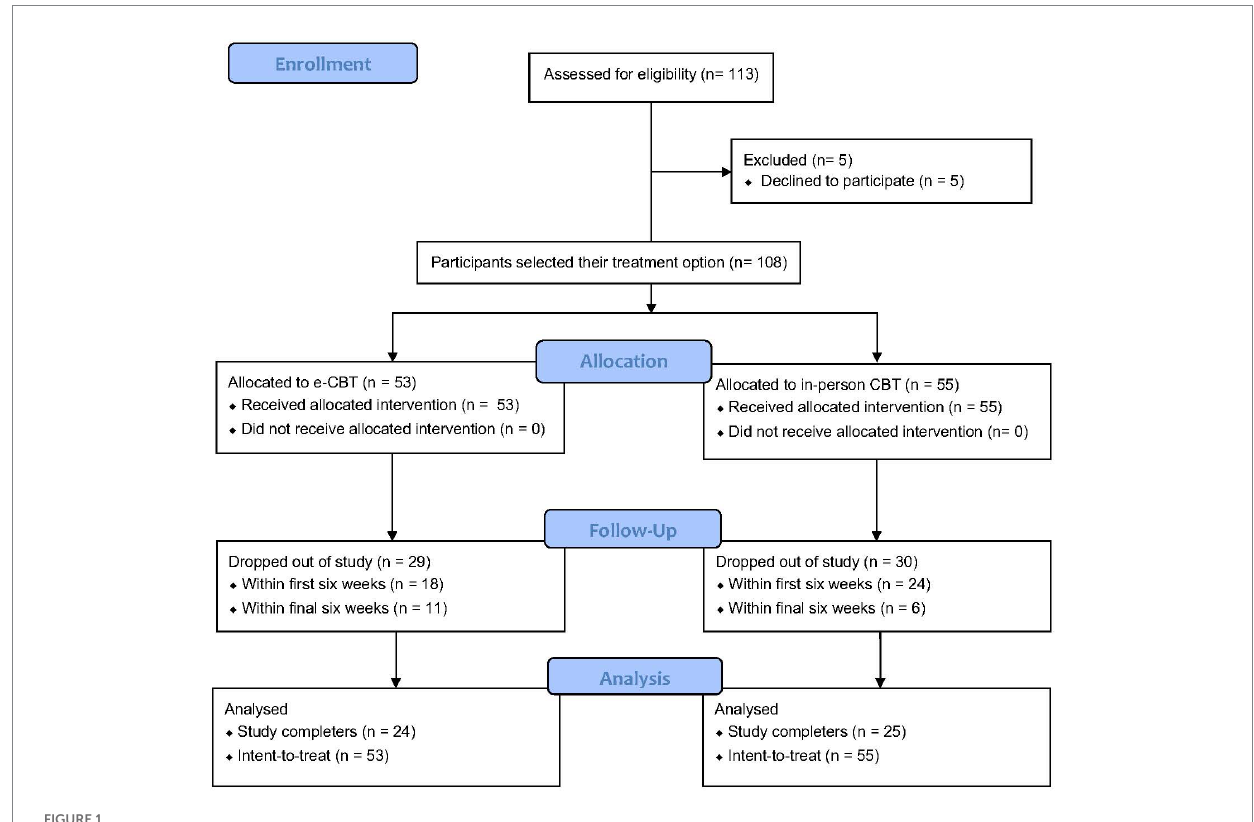
FIGURE 1 CONSORT flow diagram of study recruitment.